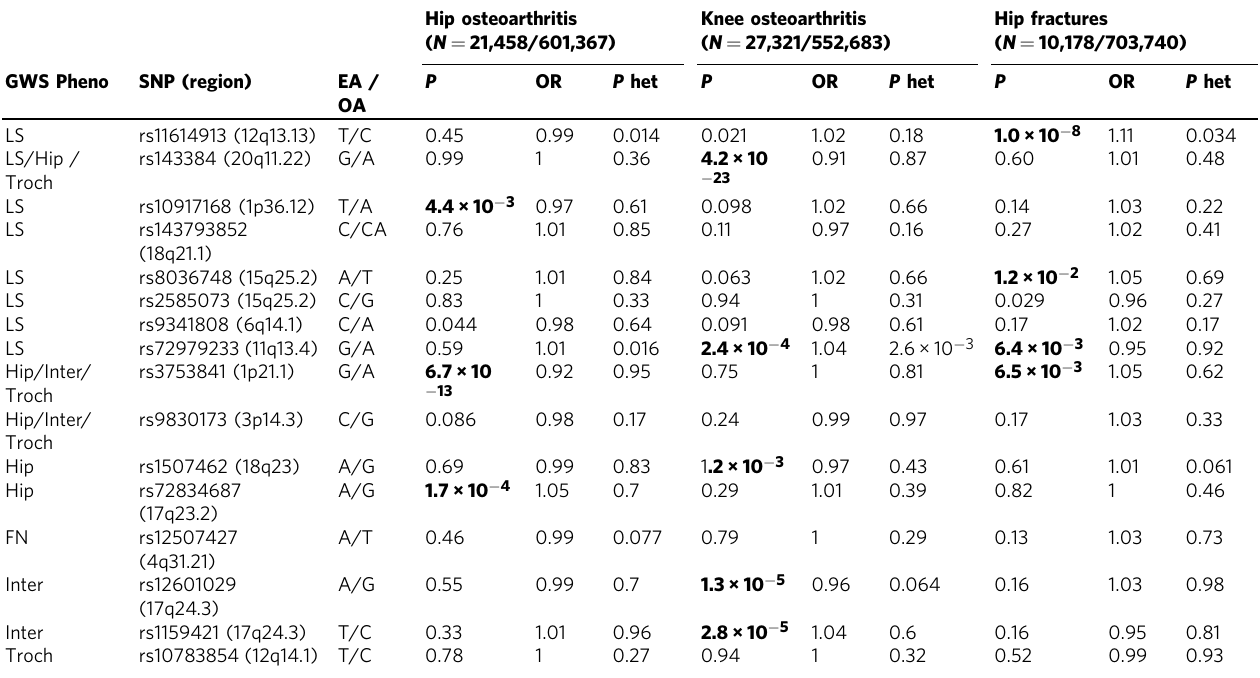
Table 2 Association of DXA bone area variants with osteoarthritis and hip fractures